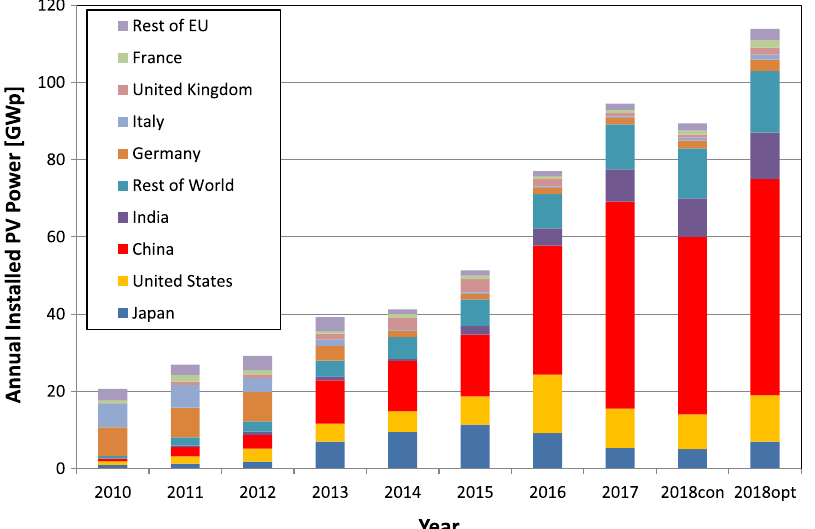
Fig. 2. Annual photovoltaic installations from 2010 to 2018 (data source: [12,13,14] and own